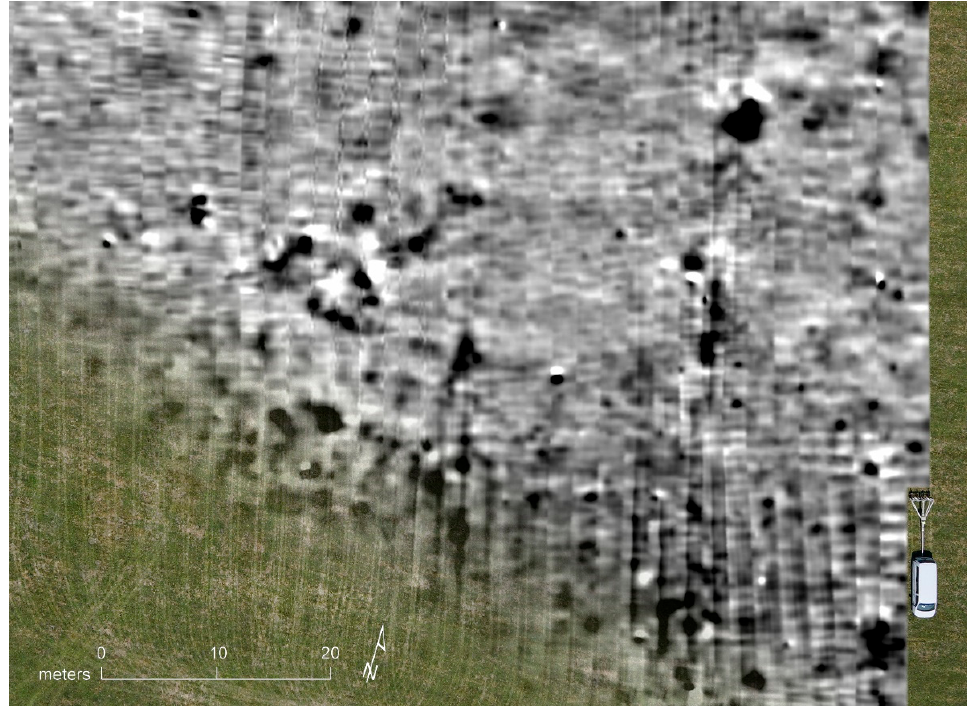
Figure 6. UAS-based aerial photograph showing the magnetometer prospection system towed by the van, superimposed with magnetic prospection data. The driven survey lines visible in the field as vehicle tracks match with the georeferenced magnetic data swaths. Due to the influence of the tow vehicle, some striping can be seen in the raw data, but the magnetic anomalies of archaeological interest are nevertheless clearly recognizable and enhanced after the application of respective filtering. Photo: Geert Verhoeven.